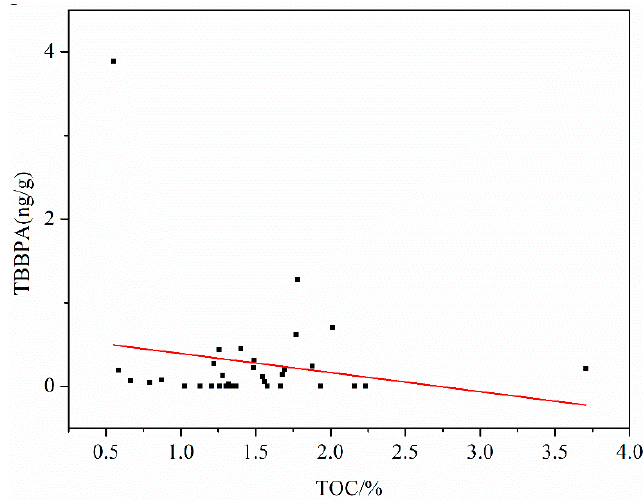
Figure 3. Correlation between TBBPA and TOC in sediment samples of the Weihe River Basin.